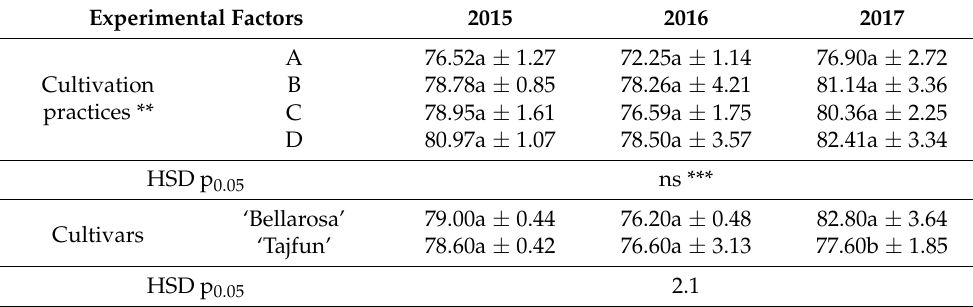
Table 6. Effects of cultivation practices, cultivars, and years on the on L* parameter of raw tubers. Experimental Factors